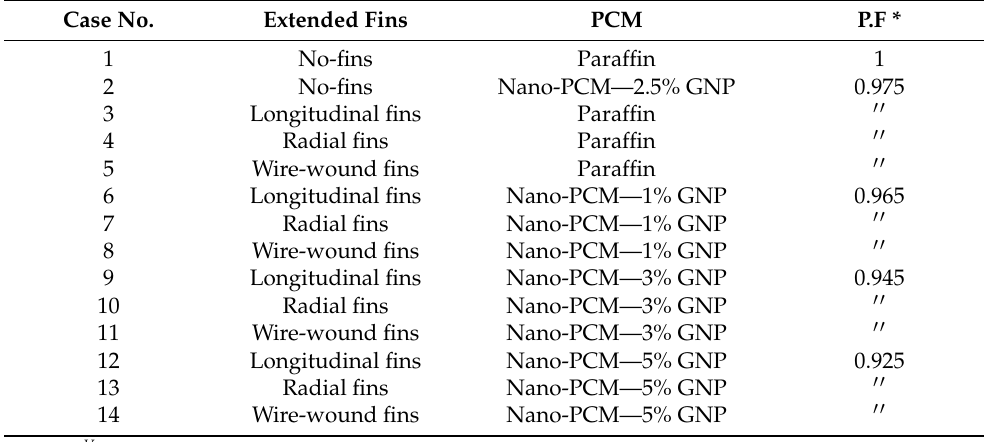
Table 2. Number of coupled enhancement cases and their respective packing factor value. Case